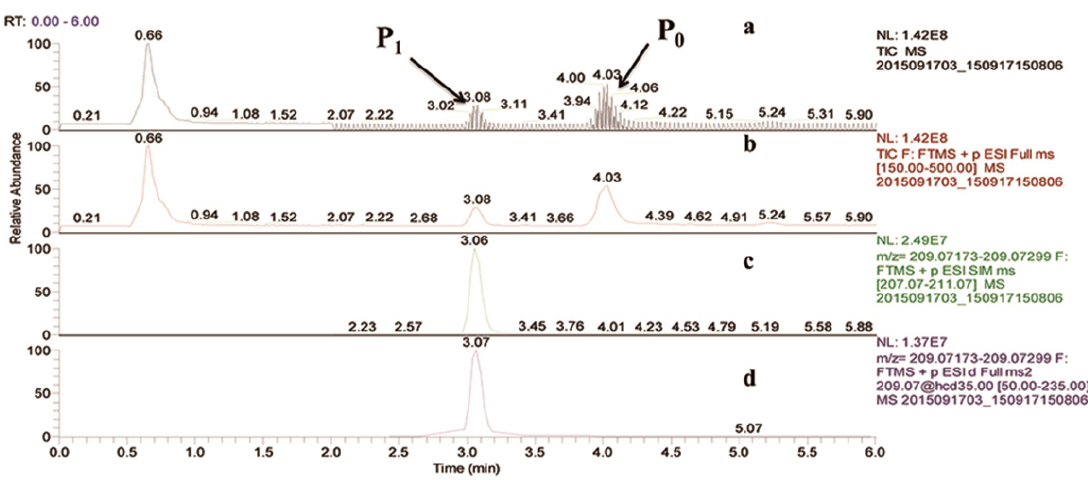
Figure 4. ( a ) Total ion current chromatogram of FBEZF degradation sample, ( b ) Full mass chromatogram, ( c ) Mass range chromatogram MS at m / z 209.07236, and ( d ) Mass range chromatogram MS 2 at m / z 209.07236.